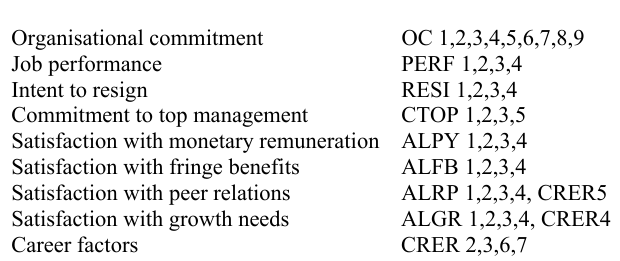
Table 3: The empirical factor structure